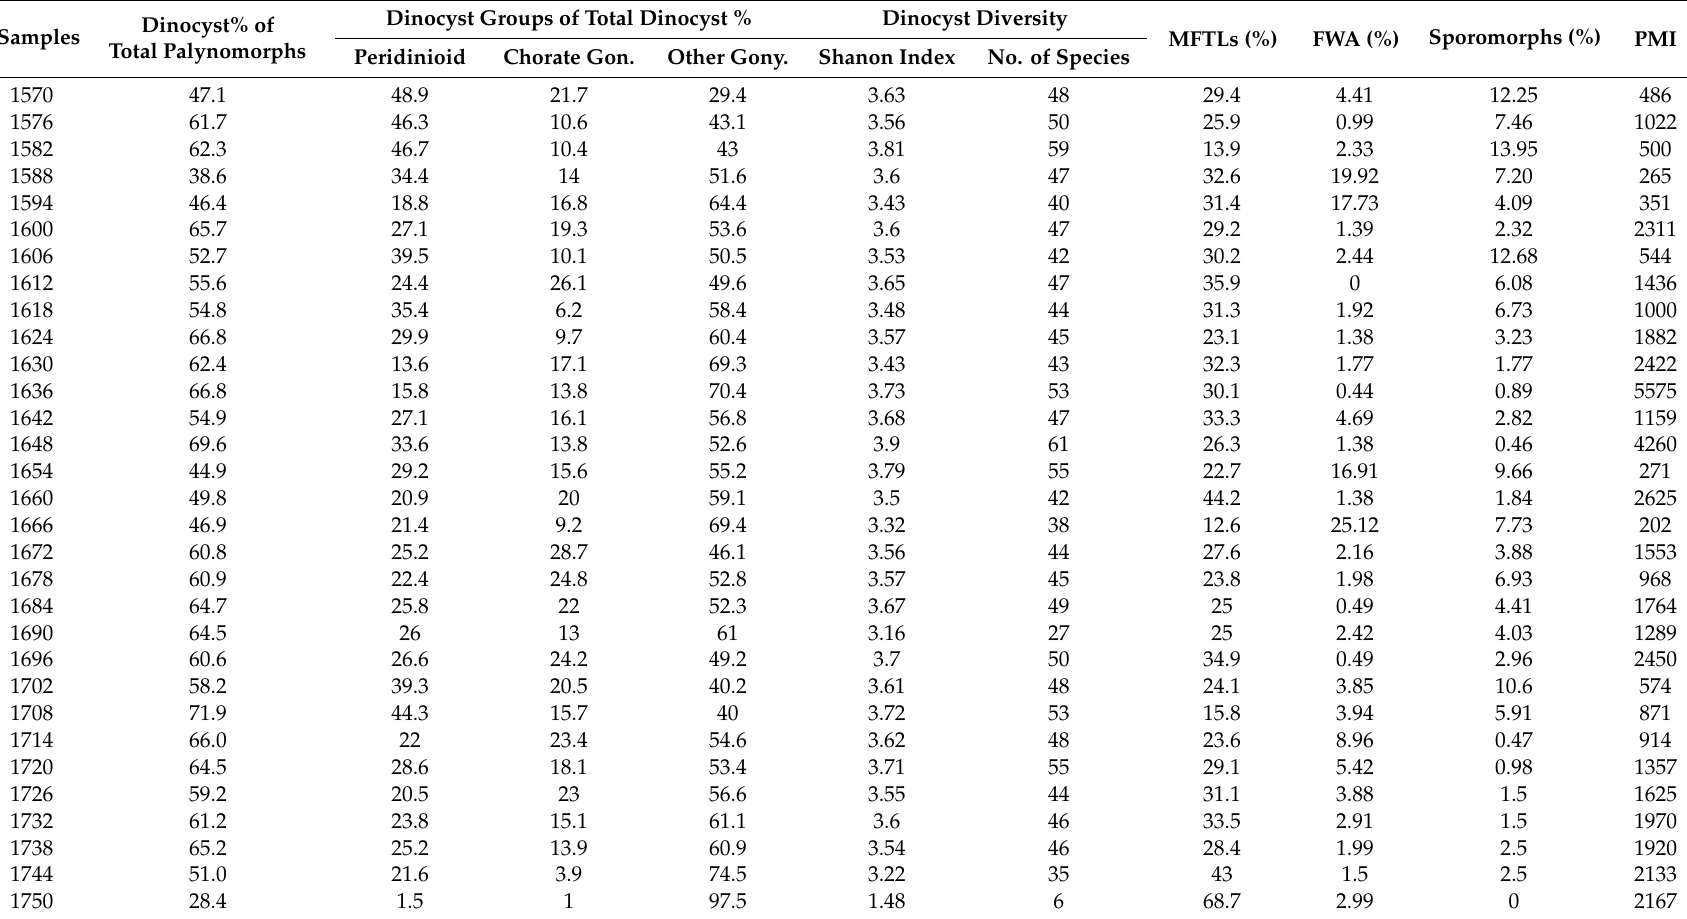
Table 1. Counted palynomorphs constituents and percentages encountered within the studied succession from the BED 2–3 well. MFTLs = Microforaminiferal test linings, FWA = Freshwater algae, PMI = Palynological marine